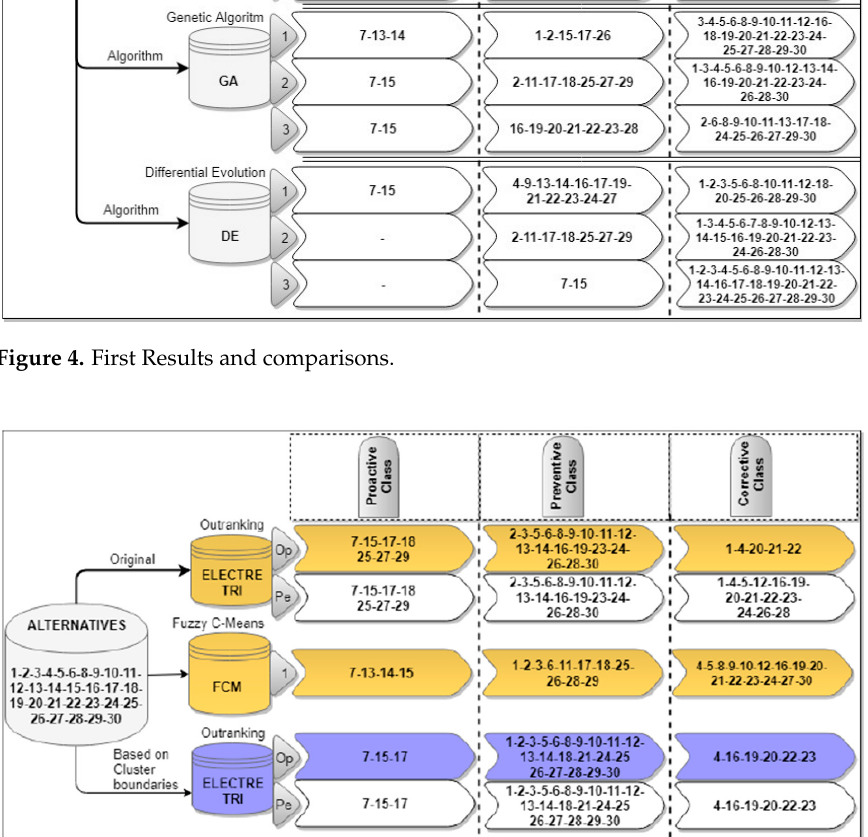
Table 8. Definition of limits after sorting by Clustering method—FCM—Procedure 1. Benefit